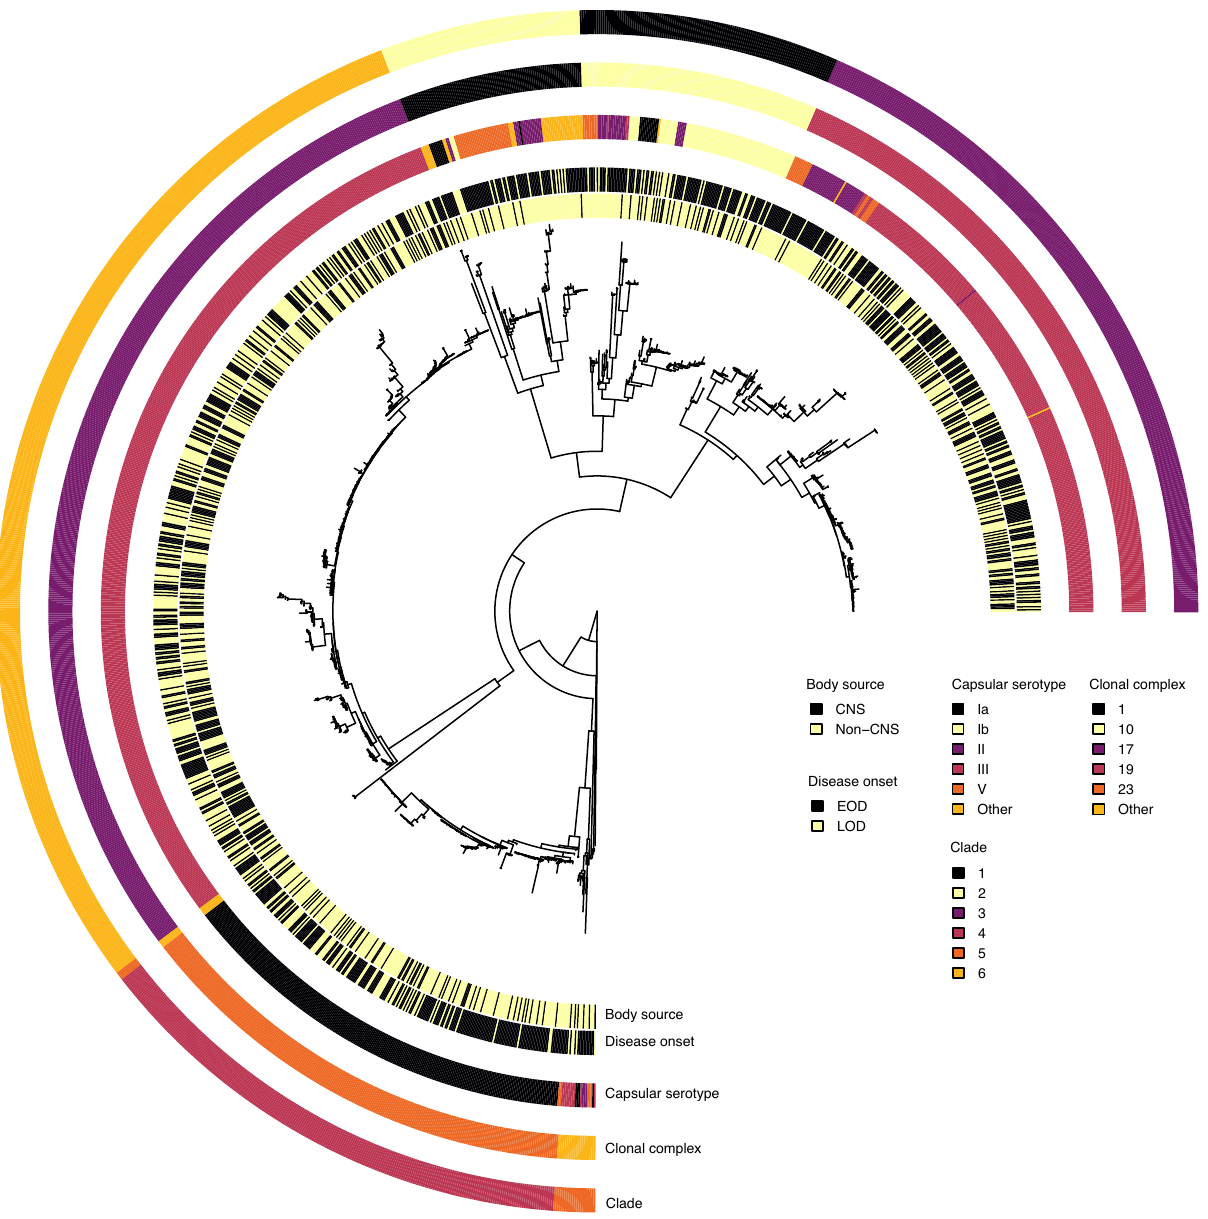
Fig. 2 Maximum-likelihood phylogenetic tree of 1,338 GBS isolates from the Netherlands. Each circular ring at the tips of the phylogenetic tree represents the body isolation site or source, disease onset time, capsular serotype, clonal complex based on the MLST approach, and the clade de fi ned based on the Bayesian clustering approach, which yielded concordant groupings with the clonal complex. The phylogeny was rooted using a genome from a related but different species, Streptococcus pneumoniae , as an outgroup (not shown in the